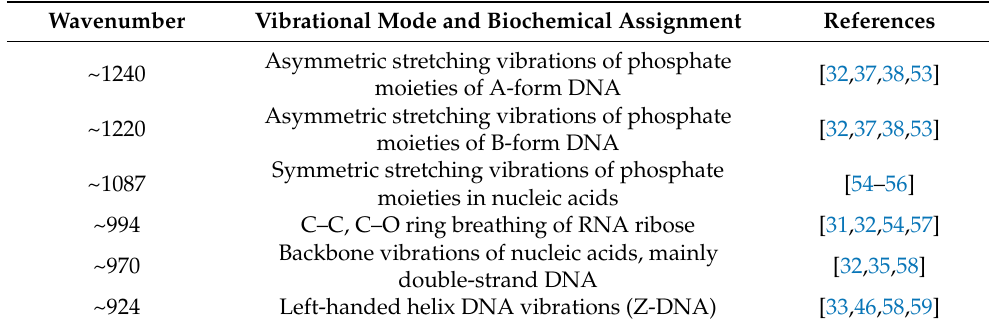
Table 3. Center position (wavenumbers), vibrational mode, and biochemical assignment of the under- lying bands as identified by curve fitting analysis of average absorbance spectra of the experimental groups in the 1300–900 cm − 1 spectral